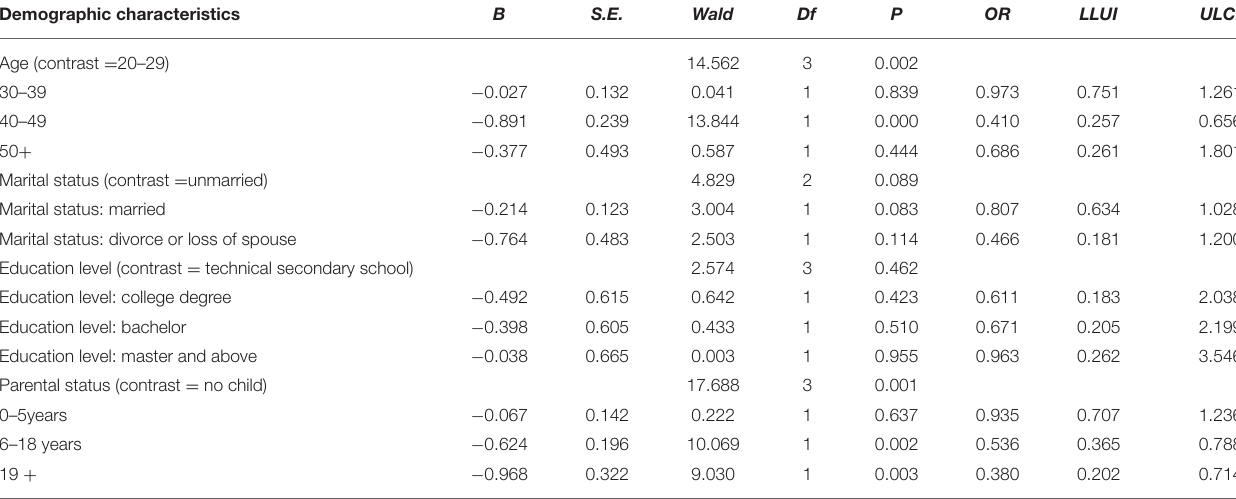
TABLE 4 | Univariate logistic regression analysis of respondents ( n = 1,133).